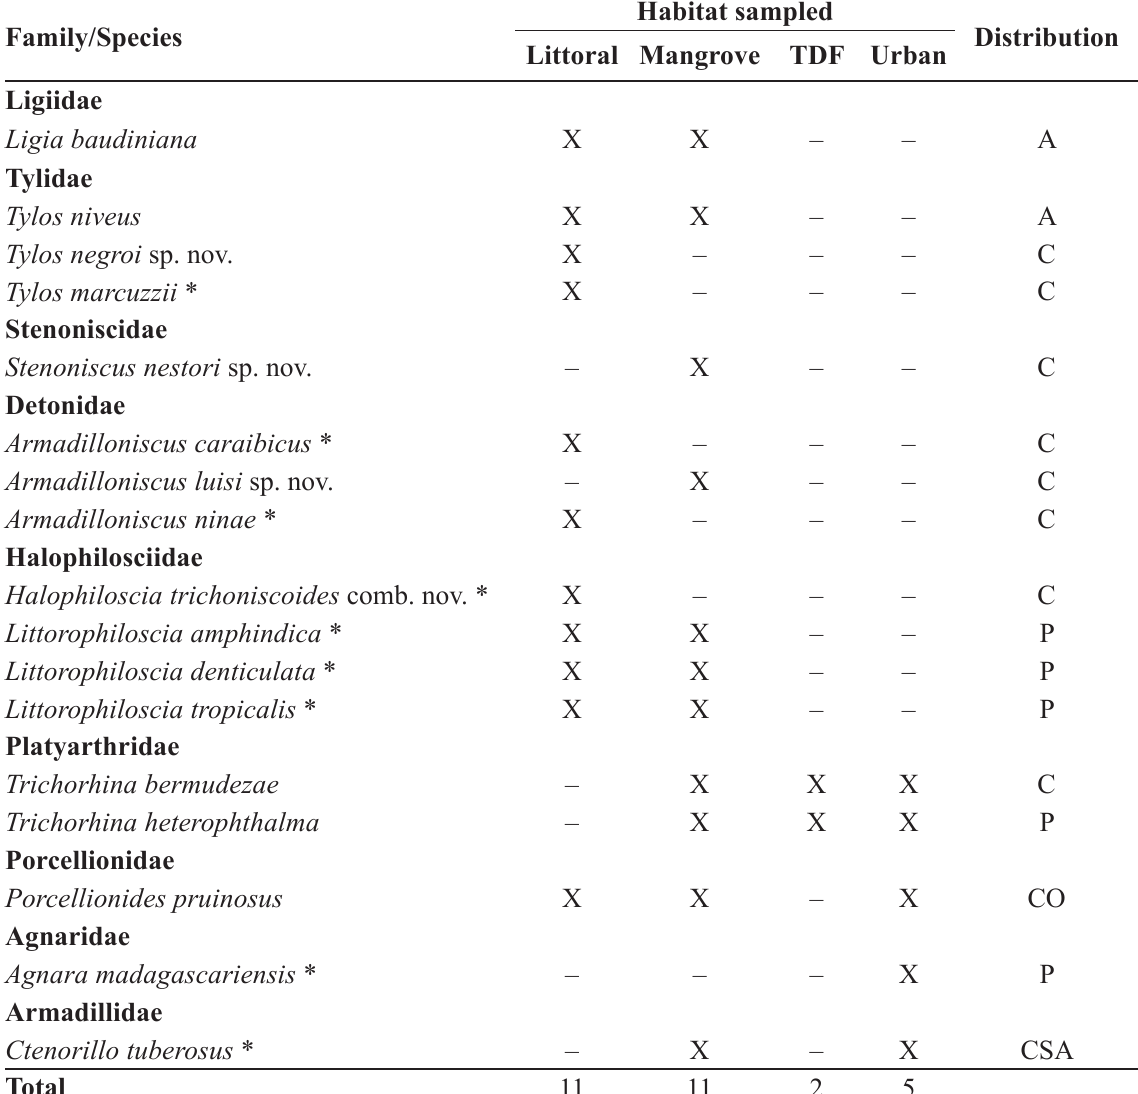
Table 1. List of terrestrial isopods from Isla Grande. Abbreviations: A = Americas; C = Caribbean; CO = Cosmopolitan; CSA = Central and South America; P = Pantropical; TDF = Tropical Dry Forest. * indicates first record for